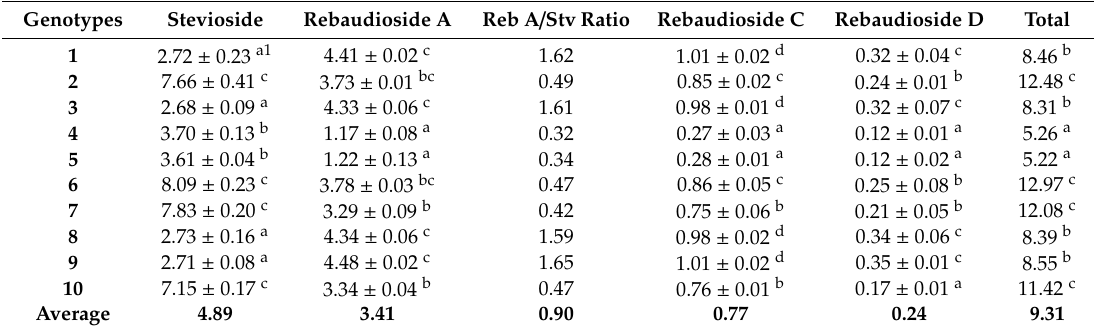
Table1. Concentrationofsteviolglycosides(%dryweight(DW))inleavesof Steviarebaudiana genotypes. Genotypes Stevioside Rebaudioside A Reb A / Stv Ratio Rebaudioside